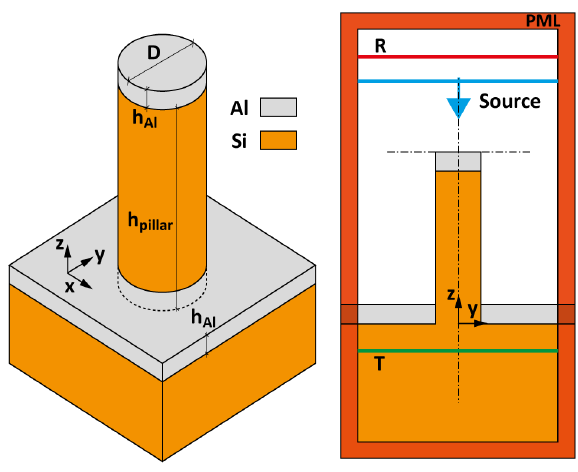
Figure 2. Nanopillar morphology used for the FDTD simulations, the diameter ( D ) is 150 nm, the height ( h pillar ) is 1450 nm, and the Al layer thickness ( h Al ) is 50 nm on the top of nanopillar and on Si substrate. On the right, the broadband plane wave source and monitors (R and T) for calculating the extinction spectrum are